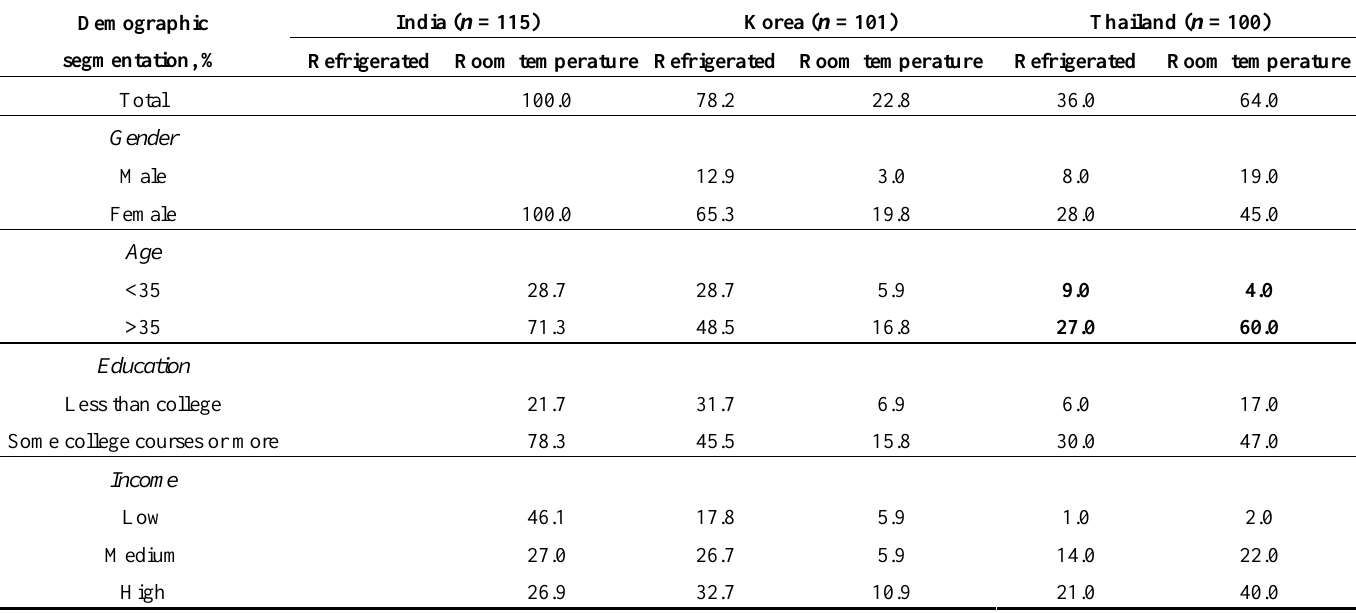
Table 3. Percentage of eggs refrigerated at time of purchase. When you usually buy eggs are they refrigerated or at room temperature?